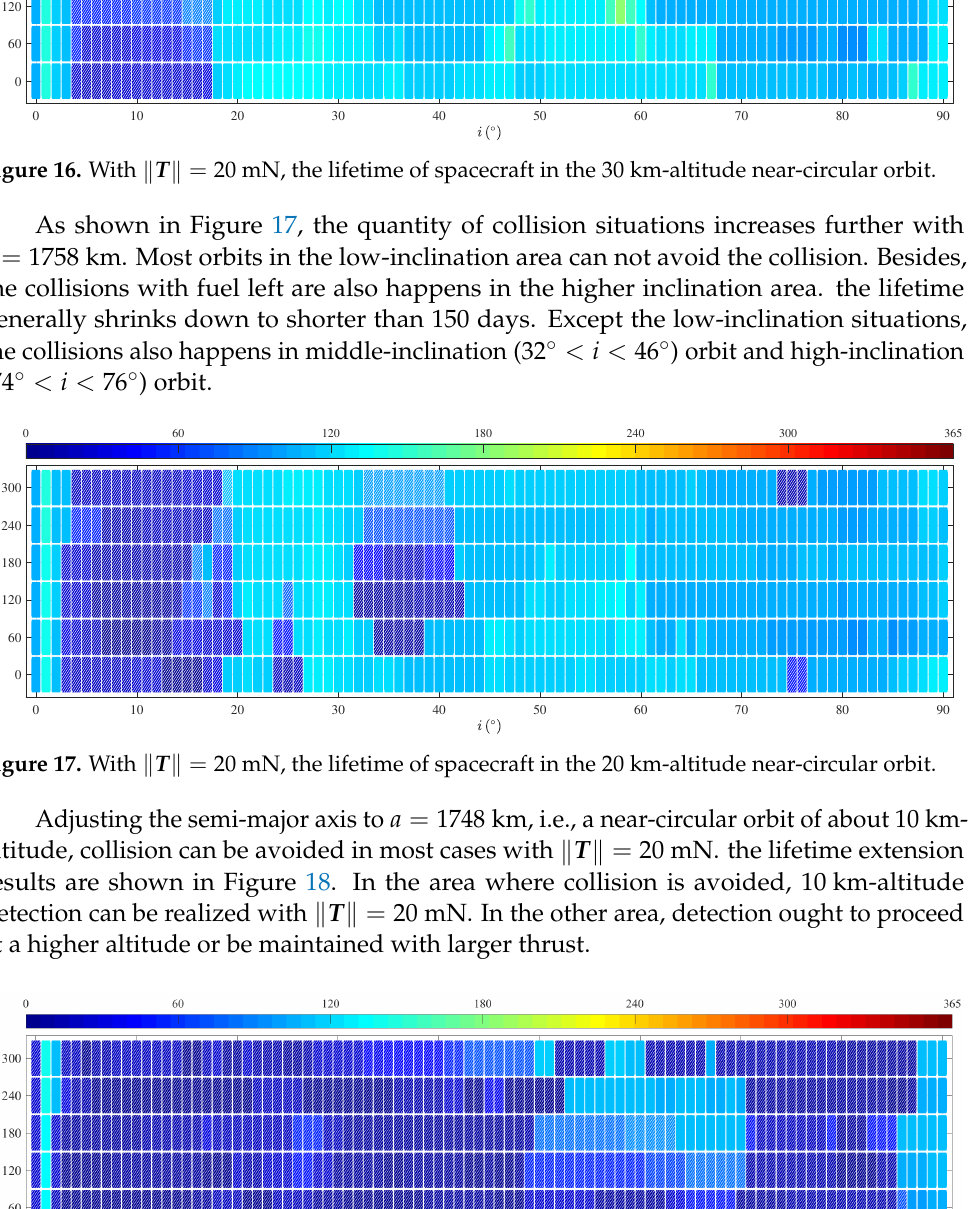
Figure 18. With (cid:107) T (cid:107) = 20 mN, the lifetime of spacecraft in the 10 km-altitude near-circular